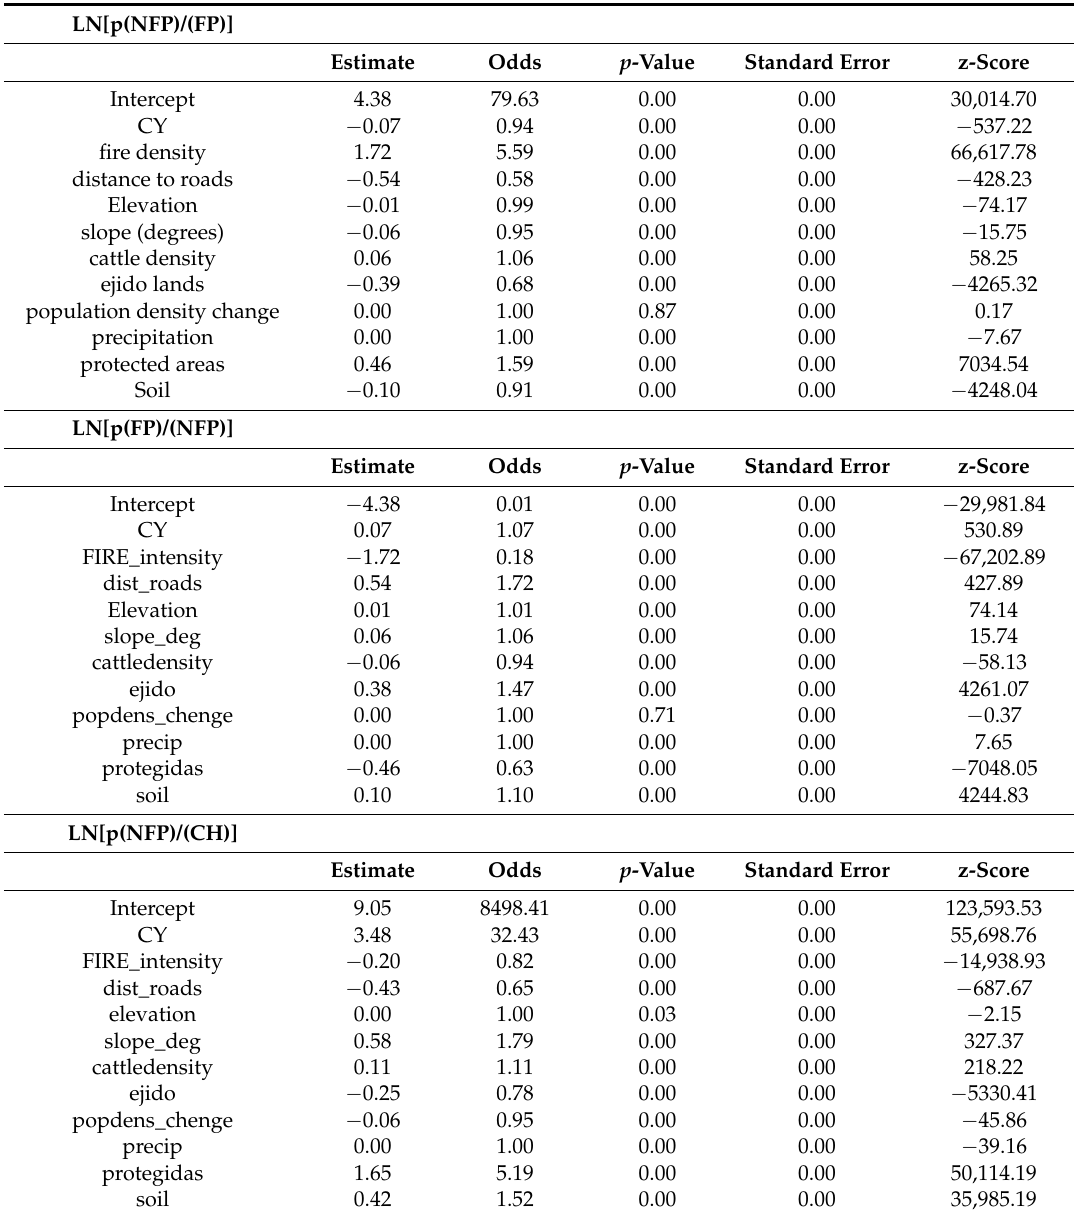
Table A1. Multinomial Logistic Model Results (variable definitions